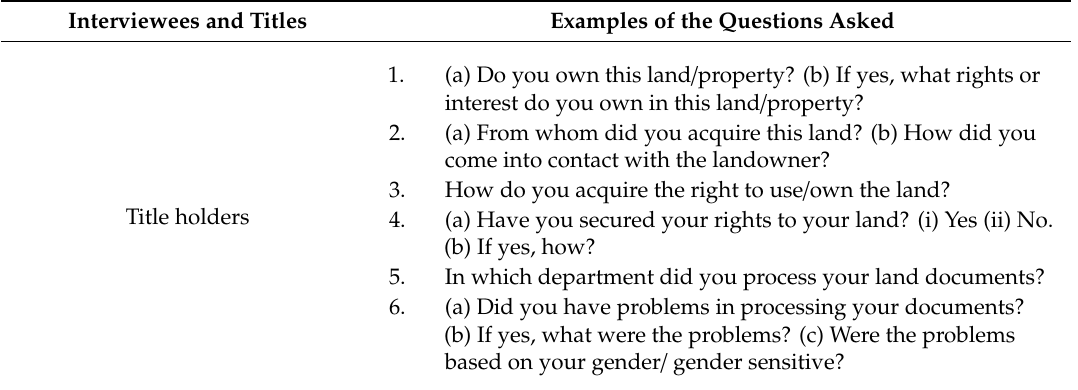
Table A2 indicates some examples of presented questions to the participants holding title to land. Table A2. Some examples of presented questions to participants holding title to